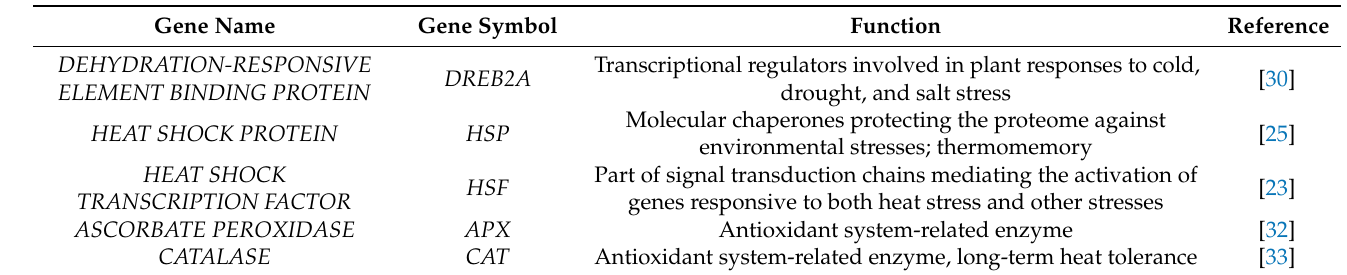
Table 1. Candidate genes and gene families for the acquisition of heat tolerance identified in Ara- bidopsis thaliana